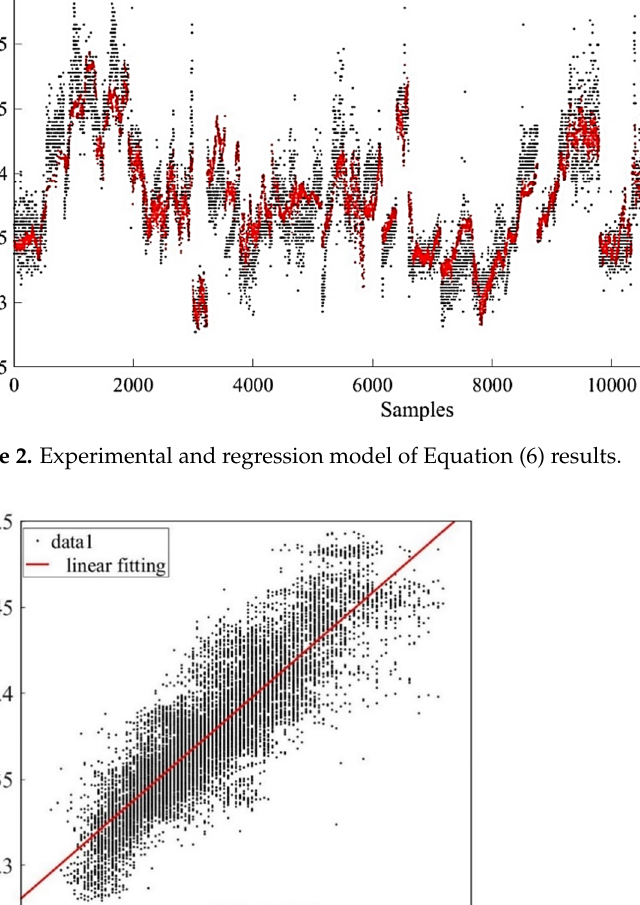
5 Table 3. Coefficient values of Equation (6). b 0